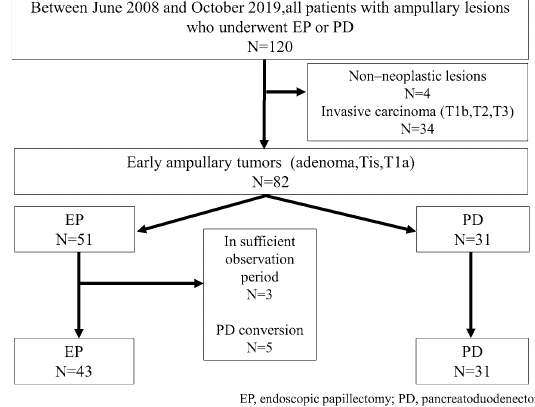
Figure 1. Study flowchart.